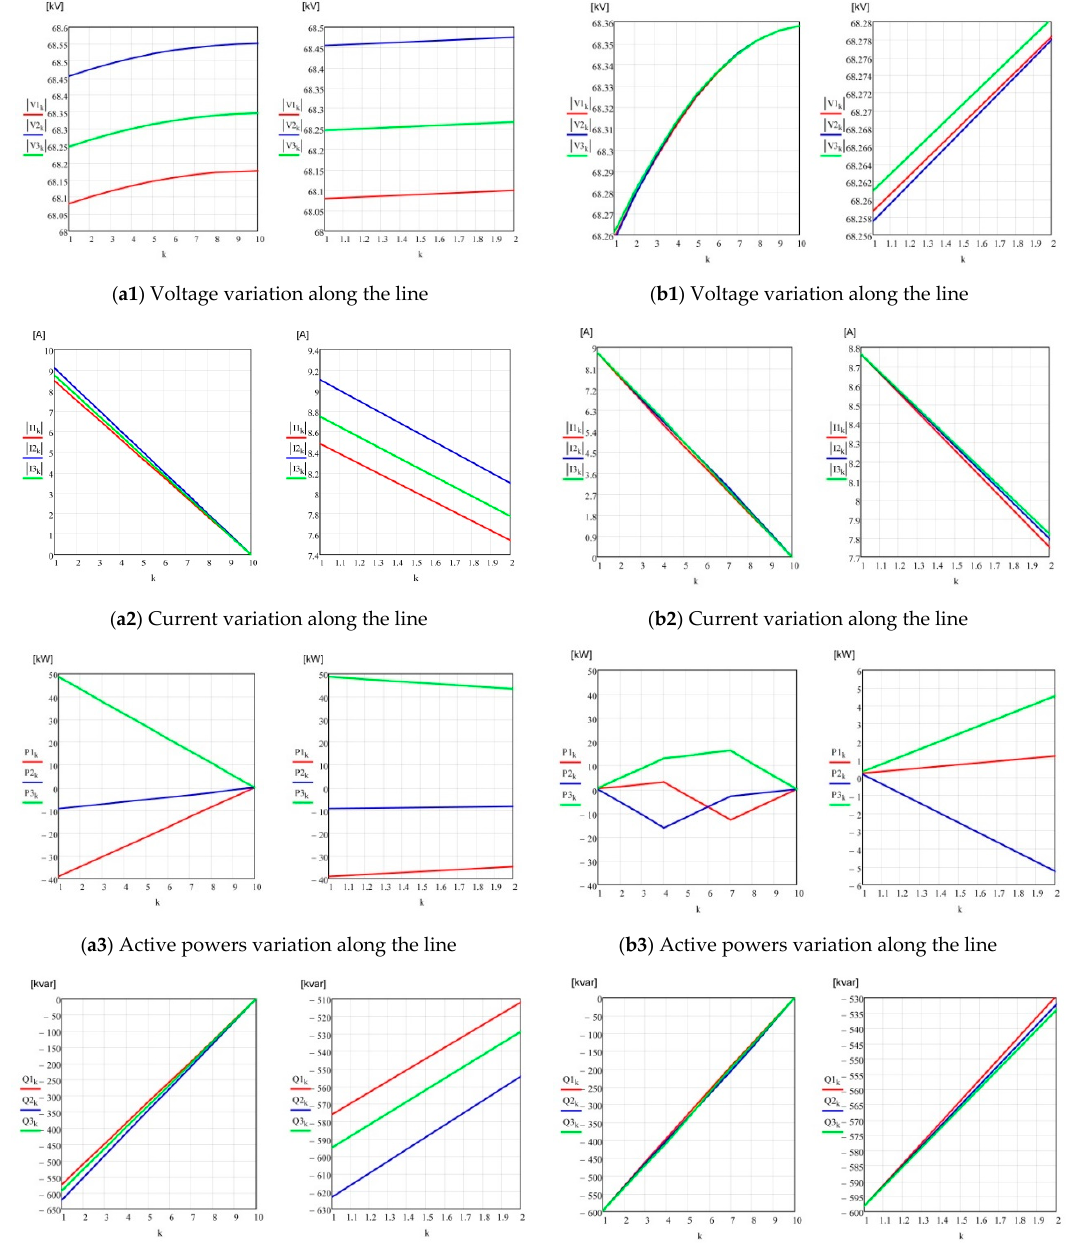
Figure 7. Results of the power flow calculation on the analyzed OHL operating in no-load conditions, performed in phase coordinates: ( a1–4 ) the untransposed line and ( b1–4 ) the transposed line.